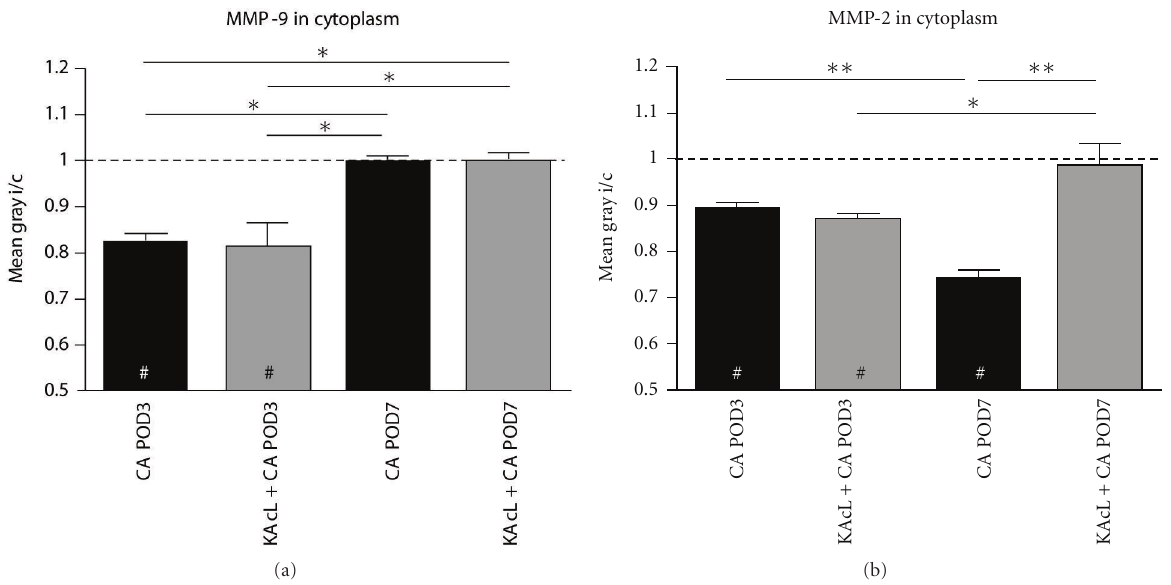
Figure 6: Statistical evaluation of the modulation of MMP-9- and MMP-2-staining intensity in the cytoplasm of AVCN neurons following cochlear ablation (CA) with or without a preceding complete lesion of VNTB (KAcL). (a, b) Bars indicate ipsilateral-to-contralateral ratios (i/c) of gray tone means of MMP-9 (a) and MMP-2 (b) measured in the cytoplasm of AVCN neurons (test field indicated in Figure 1(e)) following cochlear ablation or combination of KA injection with complete lesion of VNTB with cochlear ablation (KAcL + CA). The dashed lines mark a i/c ratio of 1, indicating control level. Whereas VNTB lesions have no influence on the loss and regain of MMP-9 from neuronal cytoplasm after cochlear ablation, MMP-2 levels return to control level by POD7 only if the reinnervation is prevented. Asterisks indicate significant di ff erences among groups, number signs (hash symbols) indicate significant di ff erences against